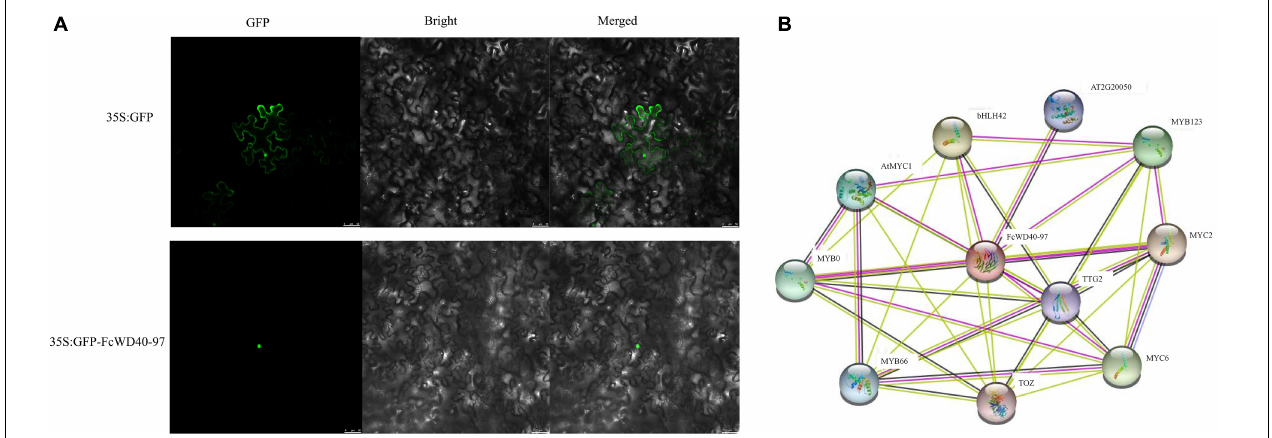
FIGURE 7 | Subcellular localization and interaction network prediction of FcTTG1. (A) Subcellular localization of FcTTG1 in Nicotiana benthamiana . Images under fluorescence (left), bright field (middle) and merged (right). Bars = 50 µ m. (B) Predicted interaction network for FcTTG1. Pink lines – experimentally determined physical interactions; yellow lines – interactions by text mining; black lines – co-expression; purple lines – protein homology.